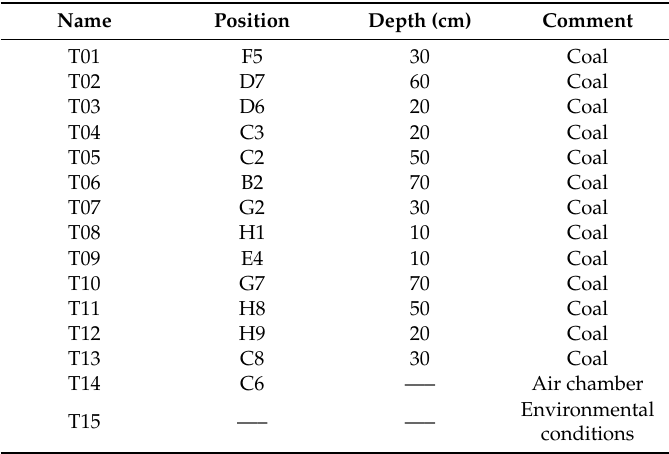
Figure 2. Plan view of the experiment setup. Table 2. Position and depth of the thermocouples installed.